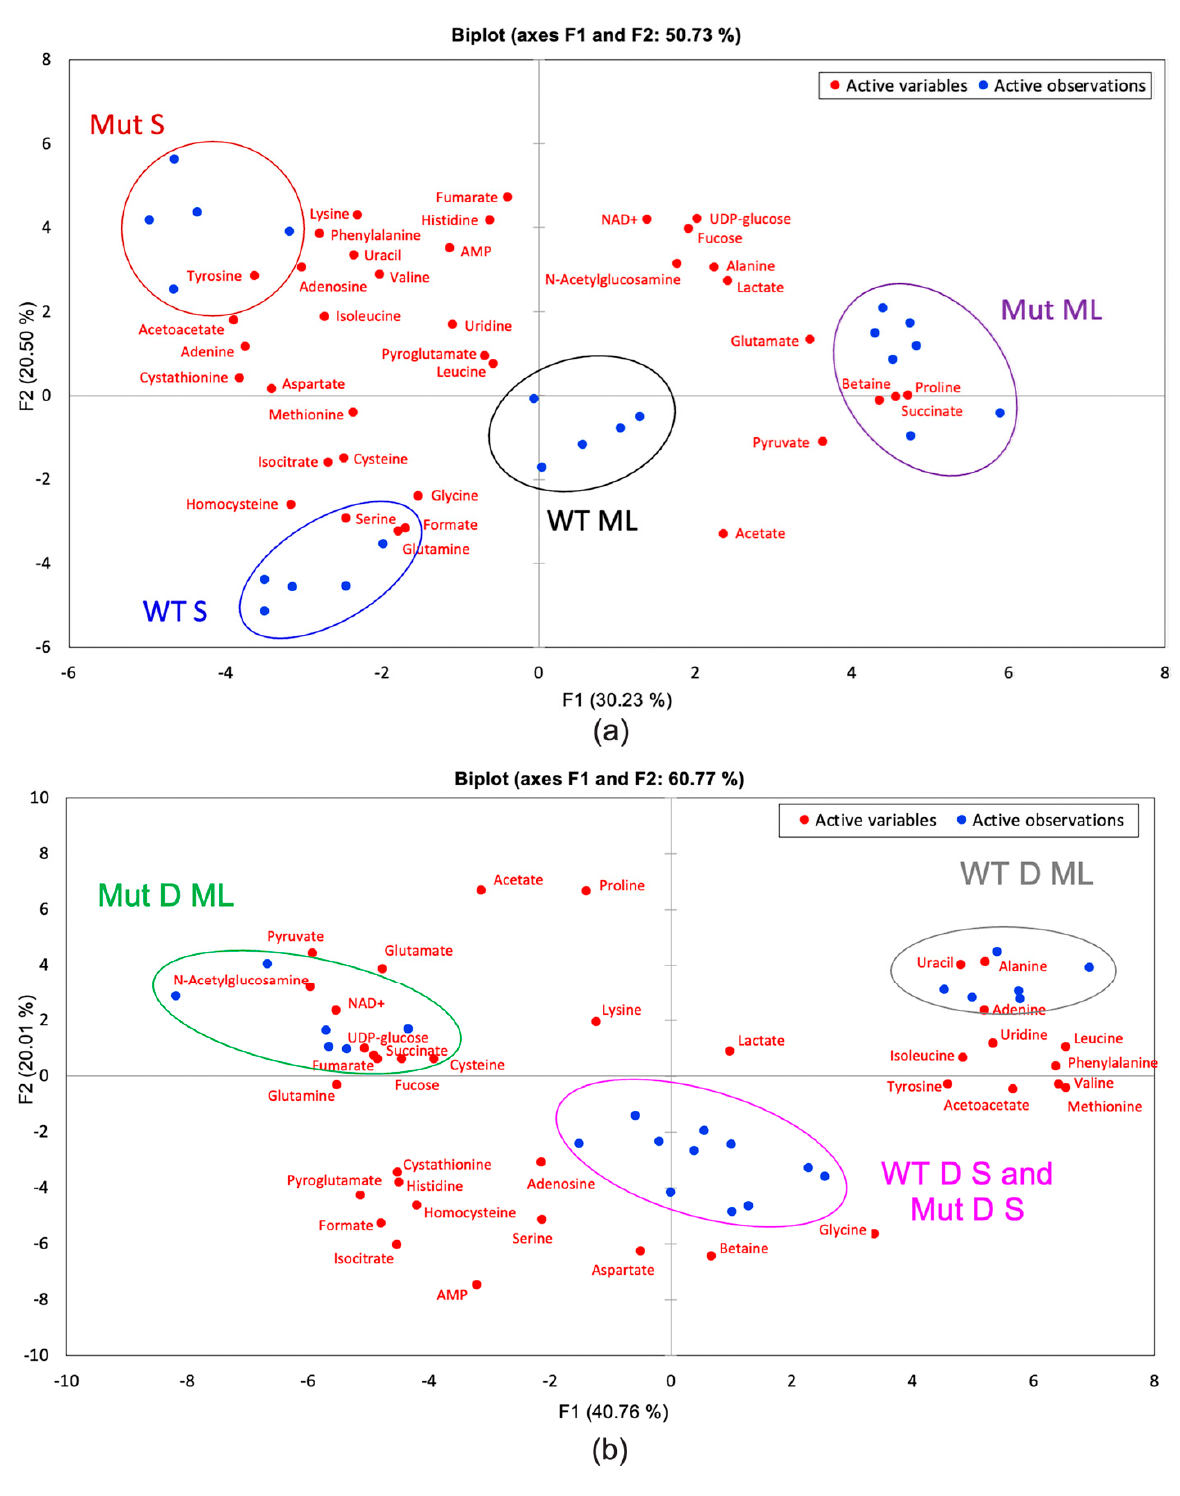
Figure 6. PCA biplots showing the distribution samples (blue dots) with color coordinated sample labels and circles and the distribution of metabolites (red dots). ( a ) Mut ML, Mut S, WT ML, and WT S samples showing complete separation. ( b ) DABCOMD-challenged samples showing complete separation of WT D ML and Mut D ML, and the overlap of WT D S and Mut D S.